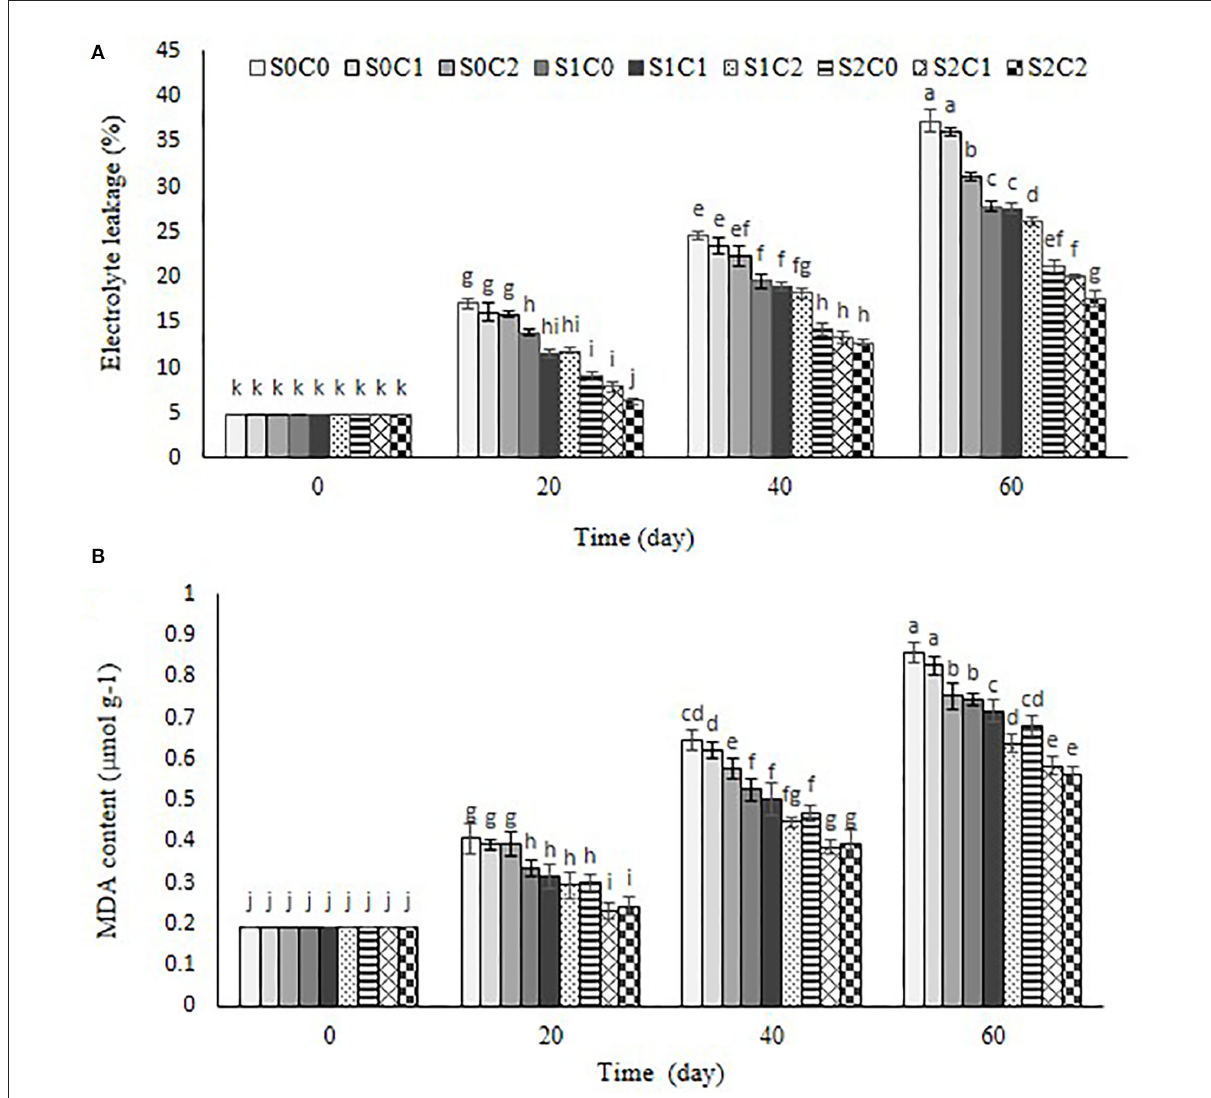
FIGURE6 Effect of foliar spraying of SA and caraway oil coating on electrolyte leakage (A) and MDA (B) during 60 d of storage at 4 ± 2 ◦ C plus shelf life (2 d, 20 ◦ C). S0C0: control, S0C1: 0.3% caraway oil, S0C2: 0.6% caraway oil, S1C0: 1.5mM Salicylic acid, S1C1: 1.5mM Salicylic acid + 0.3% caraway oil, S1C2: 1.5mM Salicylic acid + 0.6% caraway oil, S2C0: 3mM Salicylic acid, S2C1: 3mM Salicylic acid + 0.3% caraway oil, S2C2: 3mM Salicylic acid + 0.6% caraway oil. Values represent mean ± SD of three replications. Different letters indicate significant differences at the 5% level according to the Duncan